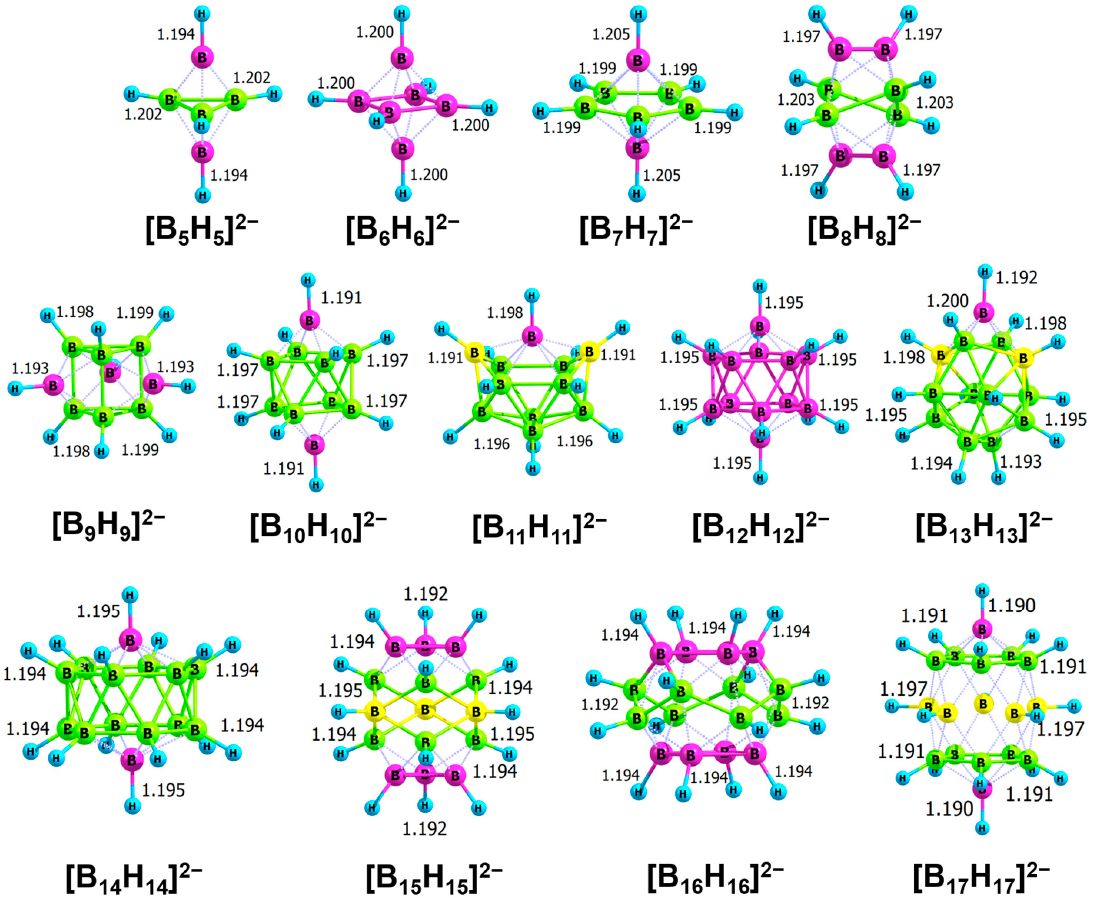
Figure 3. M06-optimized geometries of [B n H n ] 2 − (n = 5–17) dianions of polyhedral closo -boranes. Boron atoms given in violet, green or yellow color represent structural fragments with different coordination numbers of boron atom. Black numbers are B–H bond length in Å. Dotted lines represent the connection between capes and belts of a polyhedron.